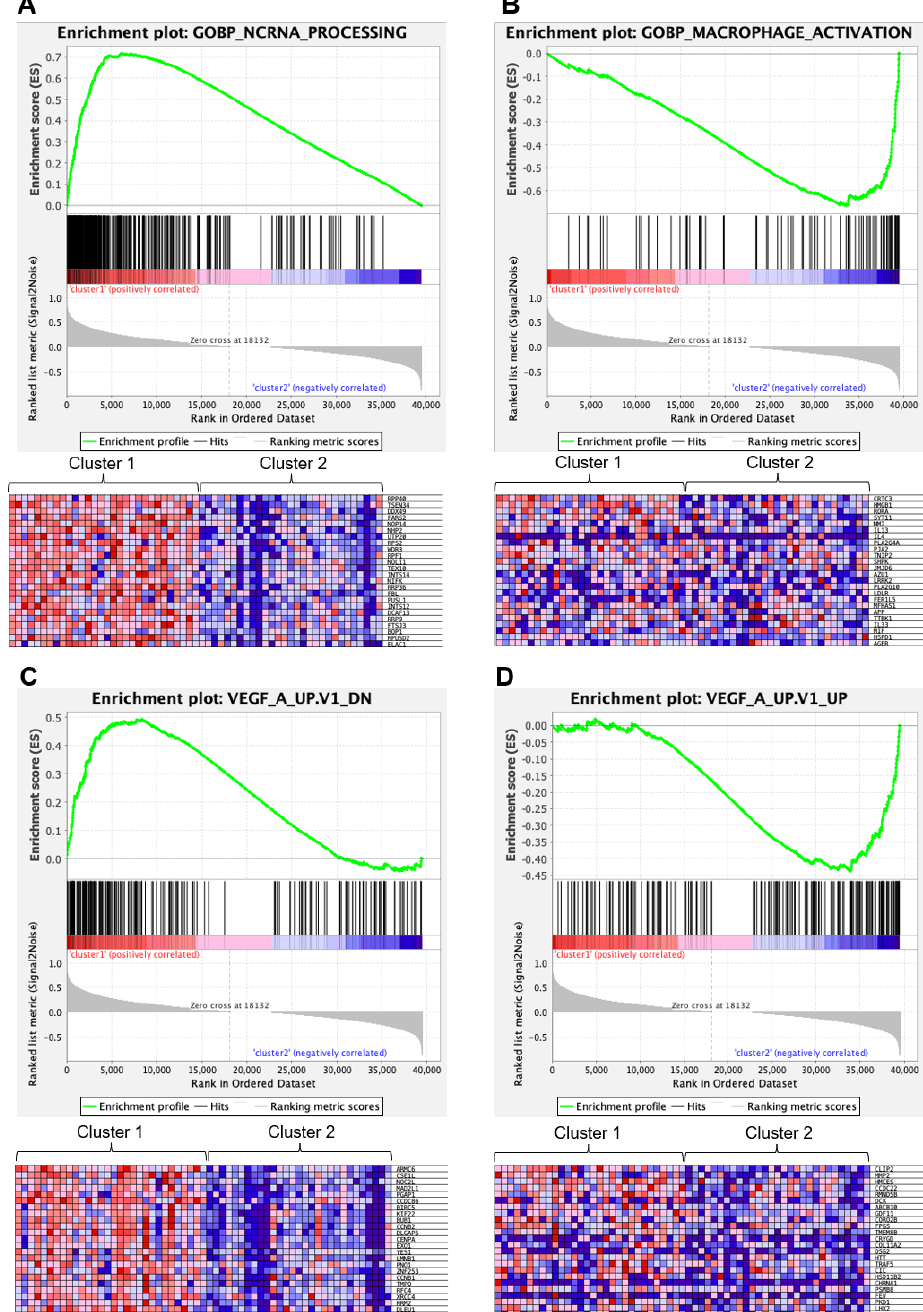
Figure 4. Gene Set Enrichment Analysis (Obtained through Gene Set Enrichment Analysis, https://www.gsea-msigdb.org/gsea/index.jsp (accessed on 1 July 2021)). ( A ) Top panel, enrichment plot for the Gene Set GOBP_NCRNA_PROCESSING (genes involved in any process that results in the conversion of primary non-coding RNA transcripts), enriched in Cluster 1. Bottom panel, a heat